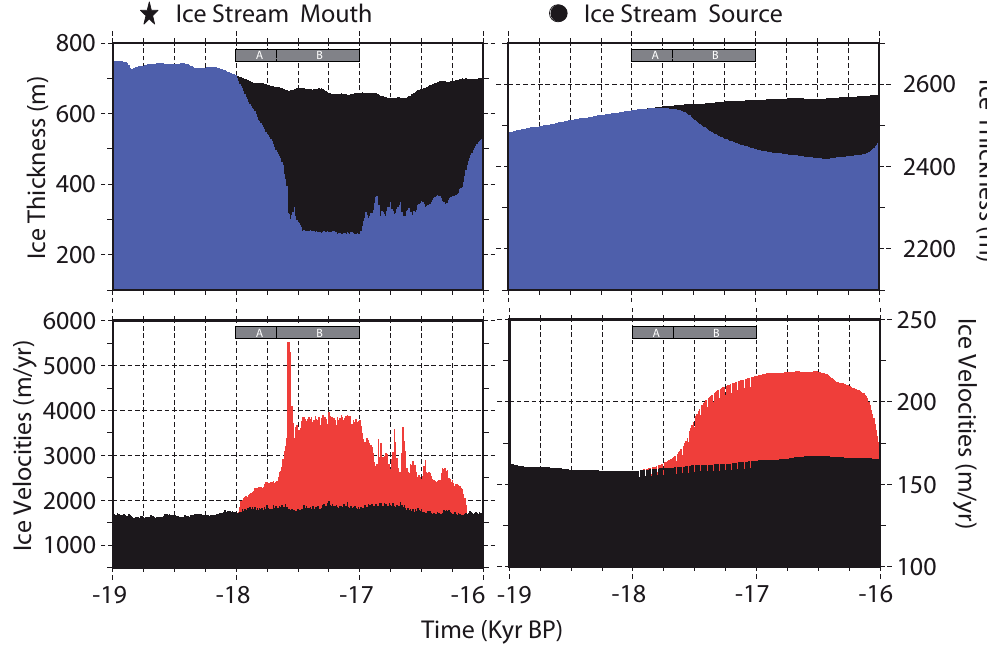
Fig. 3. Evolution of the ice thickness (in m) and velocities (in m yr − 1 ) for the perturbed simulation (blue and red, respectively) and for the standard simulation without accounting for oceanic circulation changes (black). The gray rectangle indicates the duration of the oceanic subsurface warming. Within this rectangle, (A) shows the phase of ice shelf breaking and (B) indicates the period of missing ice shelf (i.e. more than 95% of surface